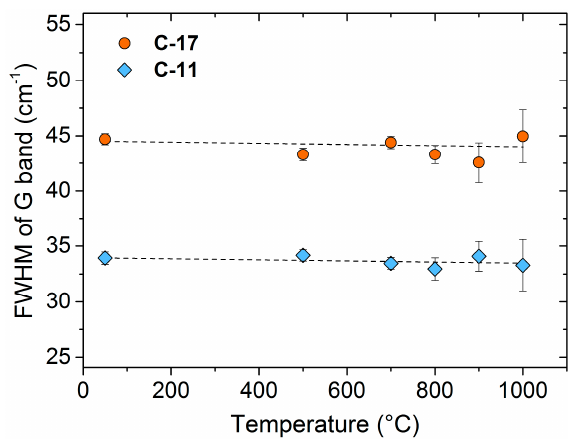
Figure 4. Temperature dependence of the FWHM of the G band of C-11 and C-17.